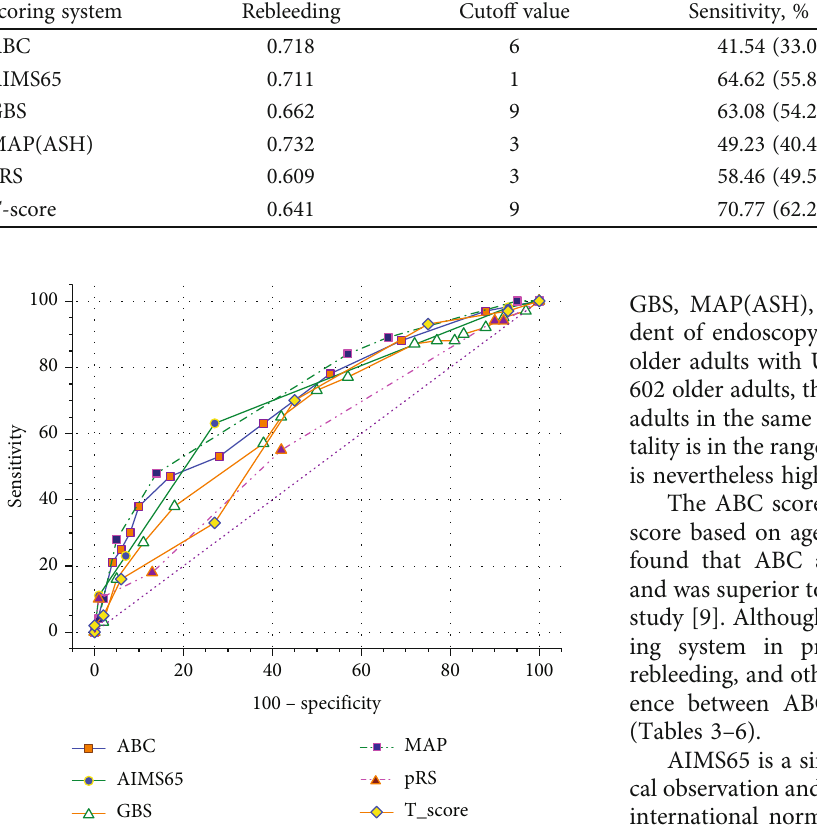
Figure 3: ROC curves for six scoring systems in evaluation of